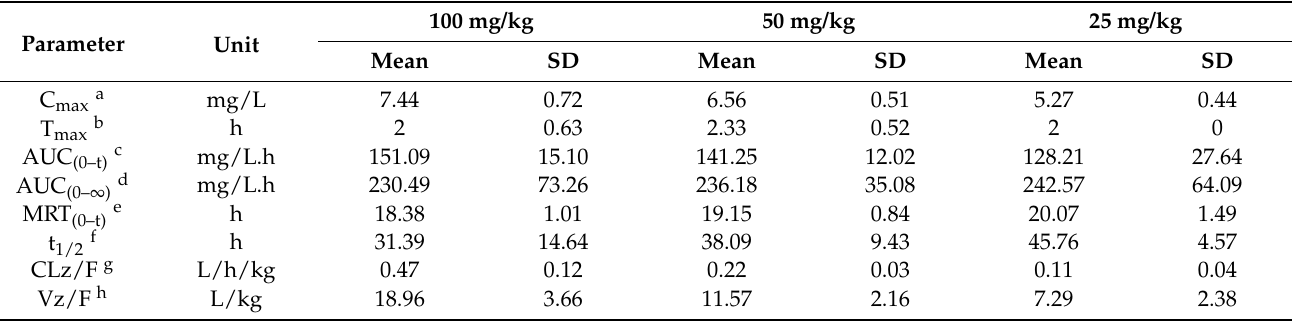
Table 5. Pharmacokinetic parameters of LBP-FITC after intragastric administration of LBP-FITC to rats at dosage of 100 mg/kg, 50 mg/kg, and 25 mg/kg.